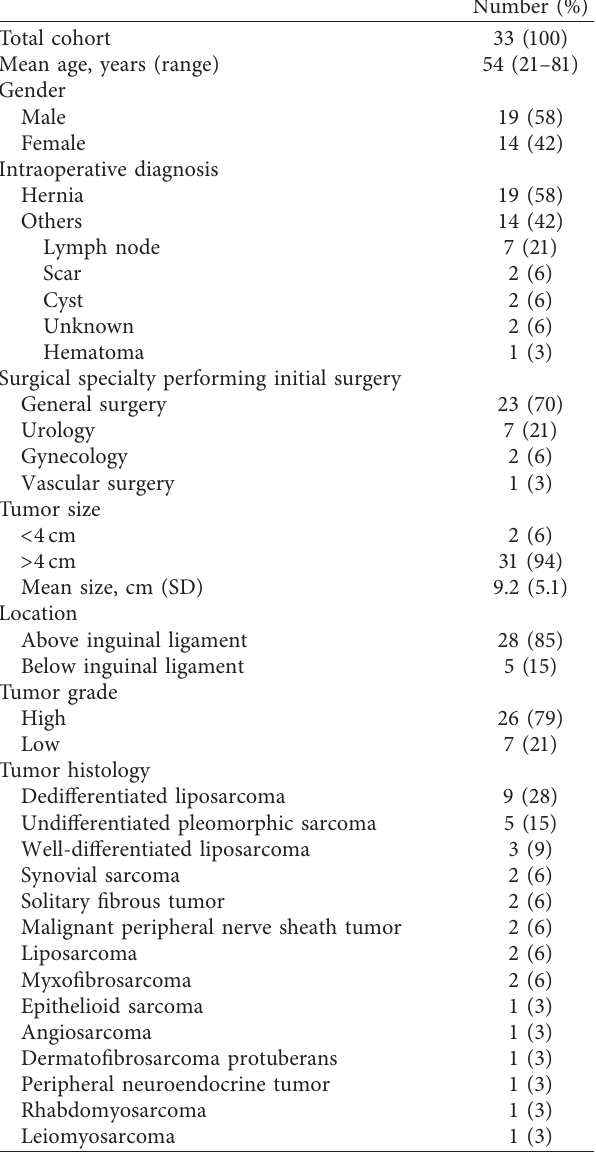
Table 1: Demographics